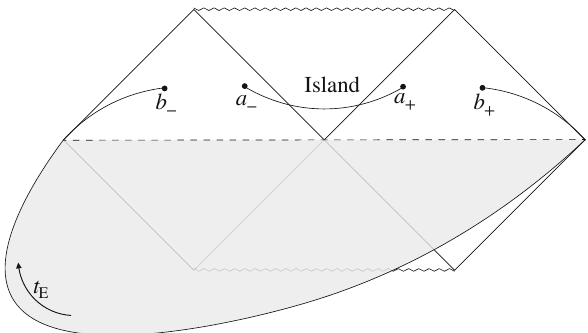
Fig. 1 The Penrose diagram of an eternal Kaluza–Klein black hole resembles the Schwarzschild’s. Every point on the diagram is under- stood to be a two-sphere. The solid curves are region of which we are computing entropy. a − and a + are the boundaries of the entanglement island. The shaded region implies that the initial state is defined by Euclidean path